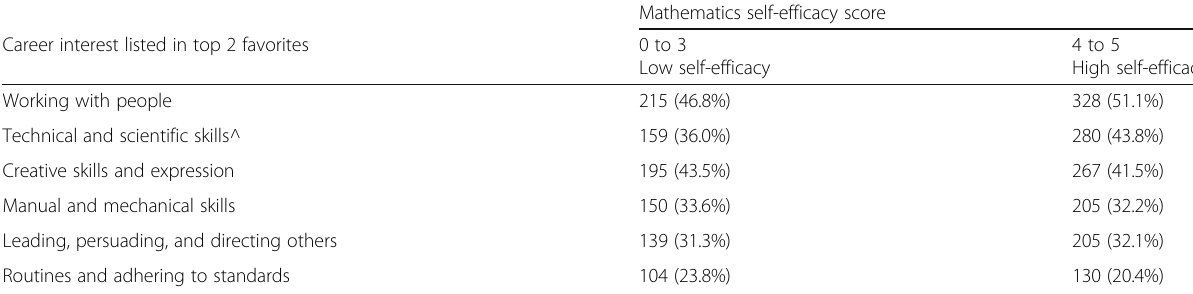
Table 7 Analysis of students ’ favored career interests by mathematics self-efficacy (MSE)